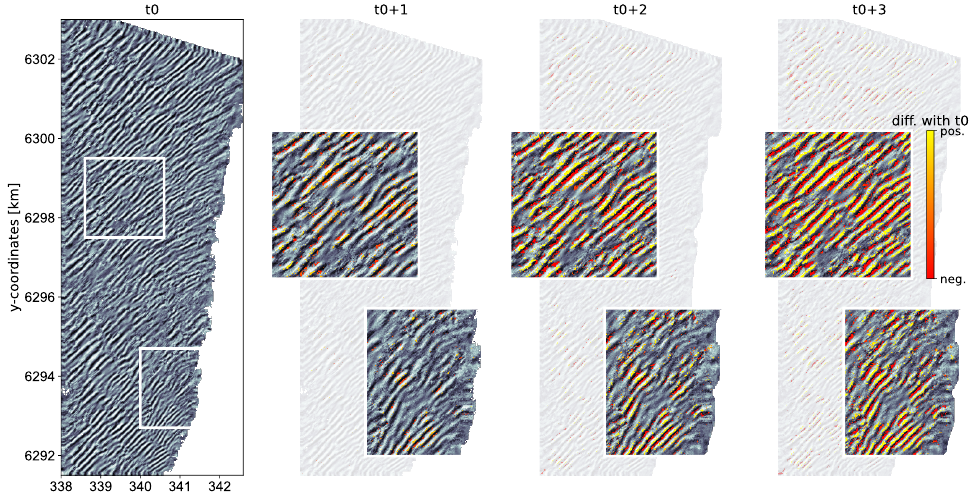
Figure 2. First four frames of the reconstructed video at times t0 = 0s to t0 + 3 = 3s. Wave movement is highlighted by zooming in on two example regions (white boxes), and looking at the difference with respect to t0 (color scale). Yellow, positive differences point out rising water levels due to incoming wave fronts. Red, negative differences point out the associated falling water levels at the back of the wave. For clarity, only differences > 10% are